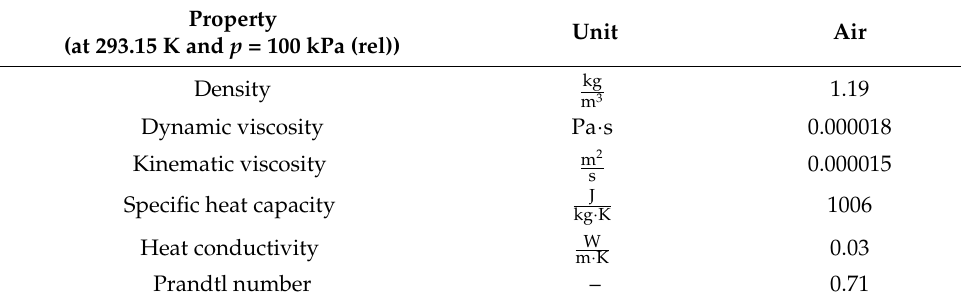
Table 1. Fluid properties of air